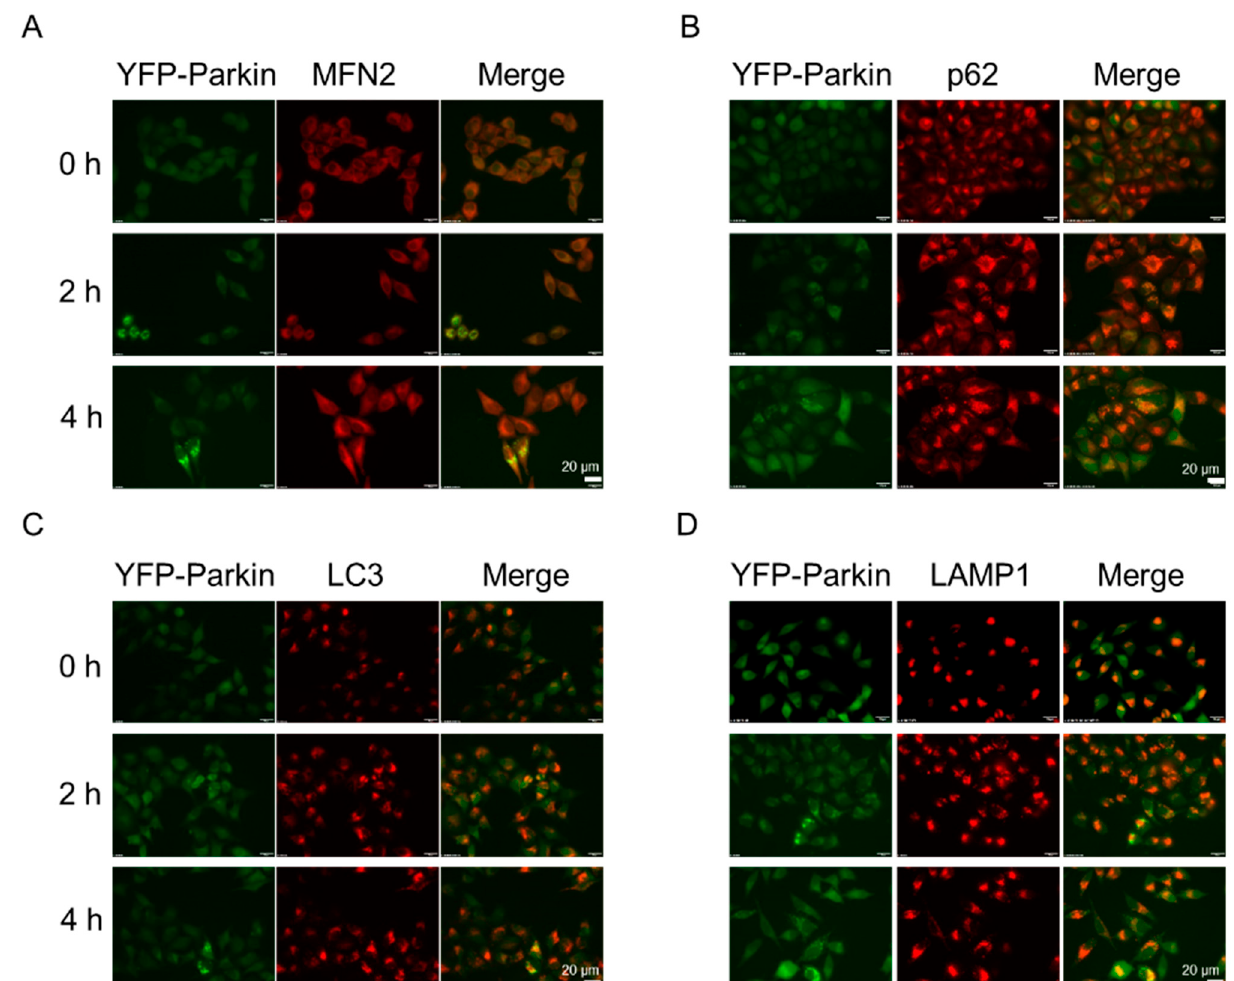
Figure 3. NJXA promotes mitochondria–autophagosome fusion. YFP ‐ Parkin HeLa cells were treated with NJXA (20 μ M) for 4 h, fixed, and stained with ( A ) MFN2, ( B ) p62, ( C ) LC3, and ( D ) LAMP1 antibodies. The images were acquired using a fluorescence microscope. Scale bar = 20 μ M.